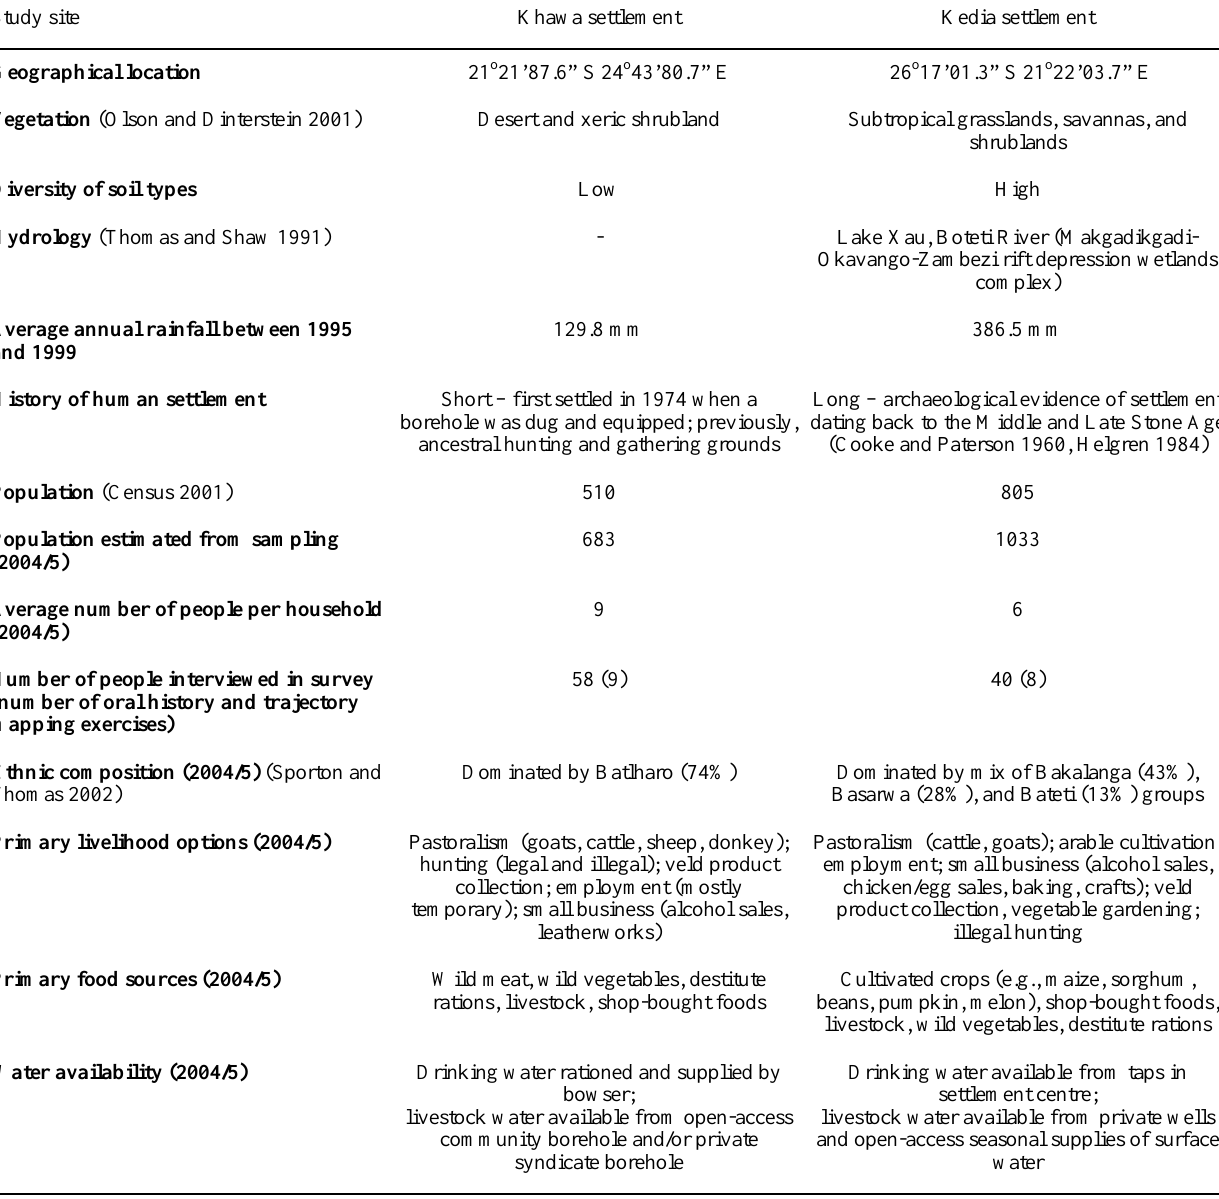
Table 1 . Study site